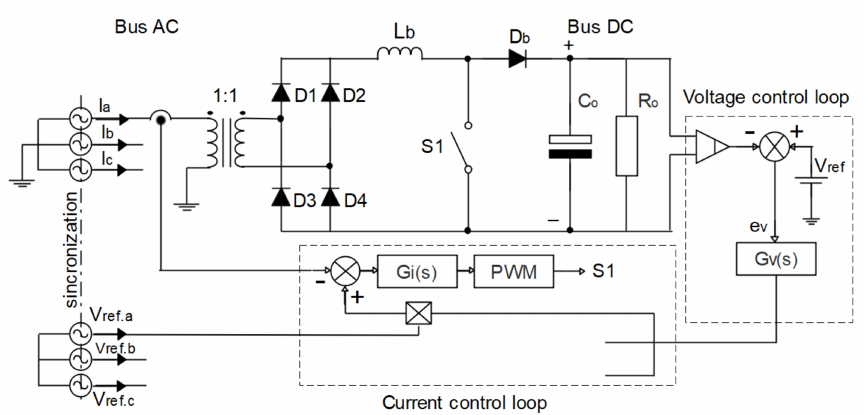
Figure 5. Modular three-phase rectifier with BOOST converter and isolation transformer.